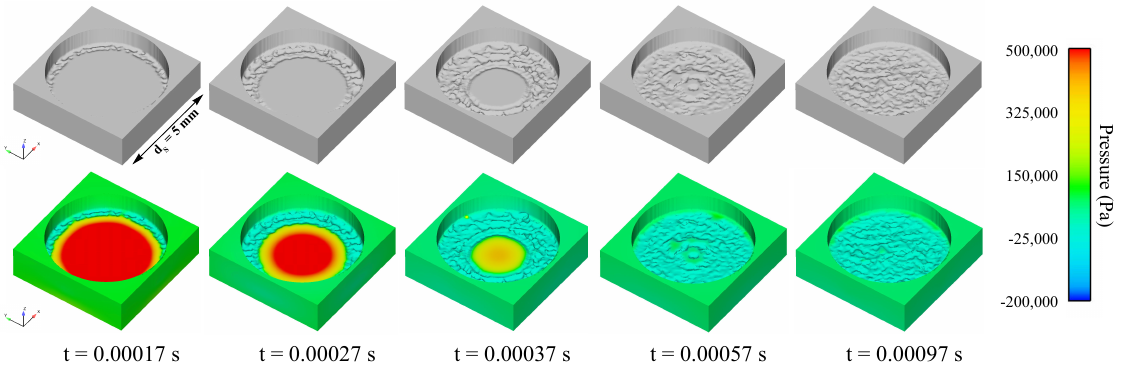
Figure 6. Expanding cavitation activity and respective pressure